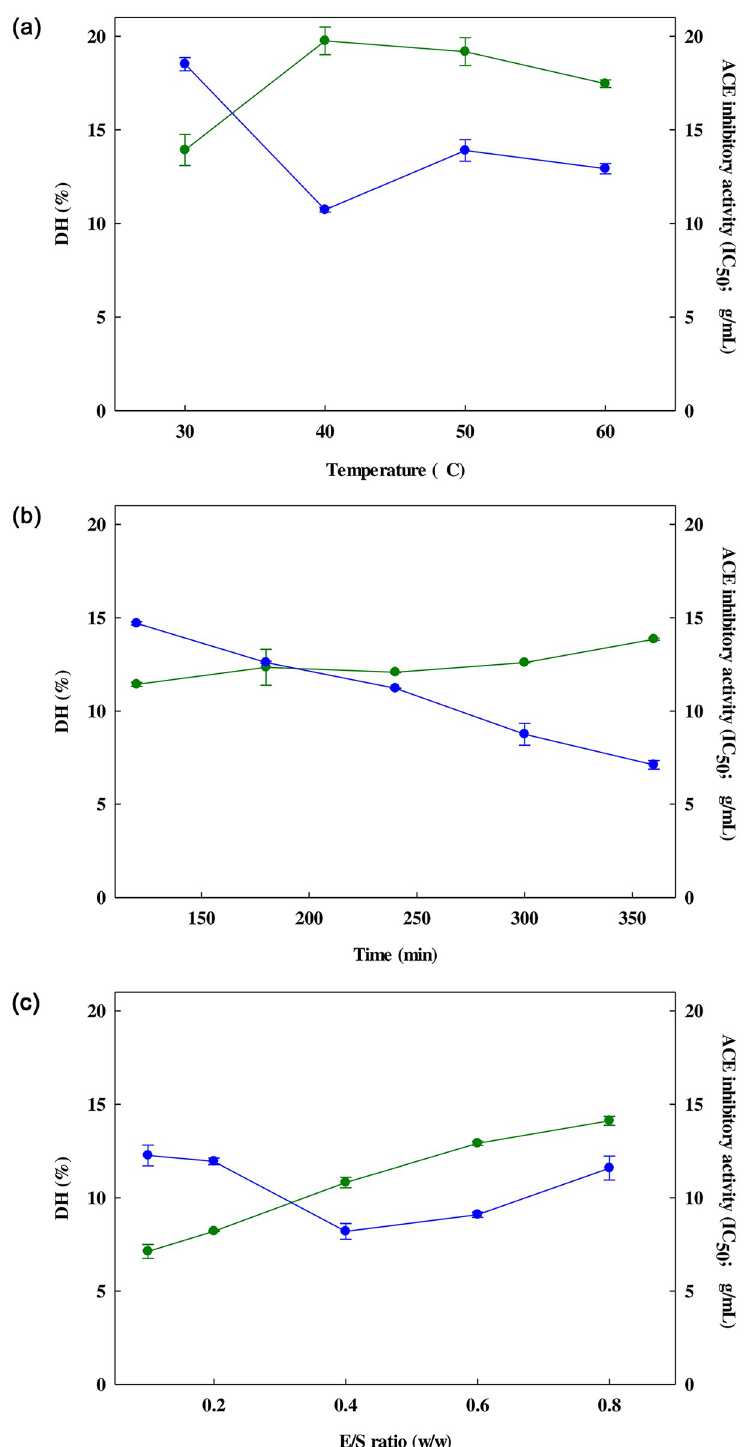
Fig 1. Influence of temperature (a), hydrolysis time (b), and E/S ratio (c) upon DH ( � ) and ACE-inhibitory activity ( � ) of the hydrolysate. Each data value is presented in the form of mean ± S.D. and the tests were conducted in